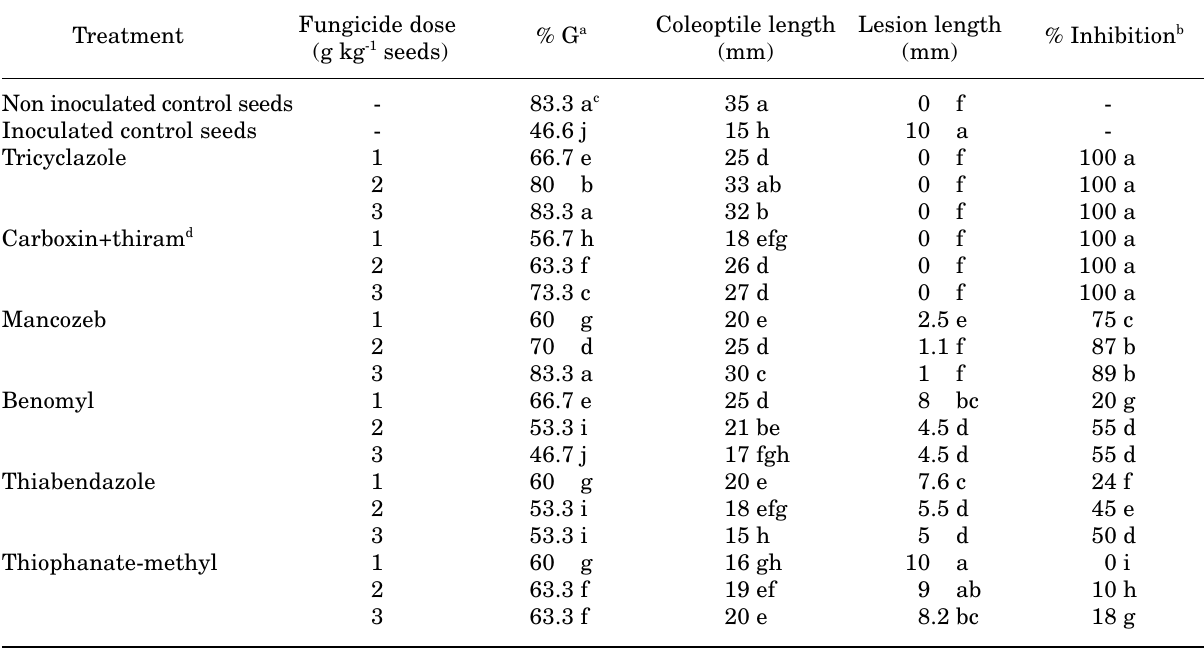
Table 1. Percent seed germination, coleoptile length, coleoptile lesion length and percent inhibition of coleoptile lesions. Seeds were treated with fungicides and inoculated 24 hours later with Pyricularia grisea. Fungicide Treatment